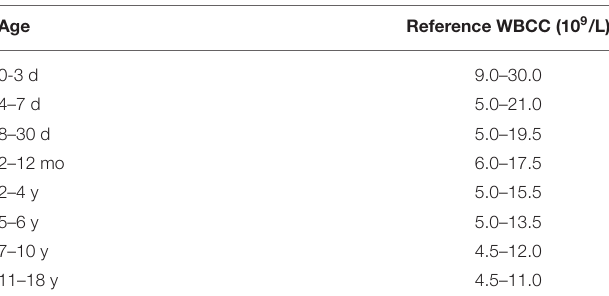
TABLE 1 | Normal reference values for WBCC according to patient